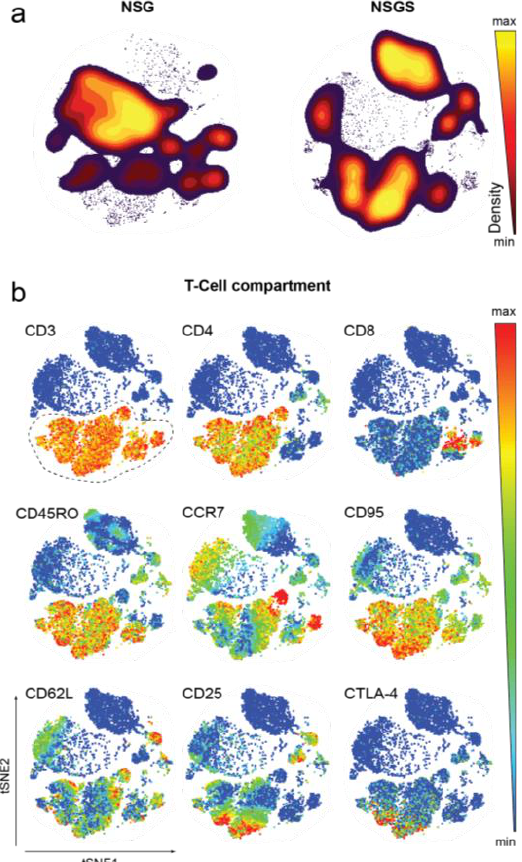
Figure 2. Characterization of peripheral T cells in NSG and NSGS mice with mass cytometry. ( a ) Contour density plots of viSNE maps showing the frequency of human immune cell populations in NSG ( n = 3) and NSGS ( n = 3) peripheral blood. ( b ) Phenotypic profiling of the T cell compartment shown for a representative NSGS recipient. The viSNE dot plots are colored according to T cell lineage and activation marker intensity. All marker expression levels are represented from high (red) to low (blue).